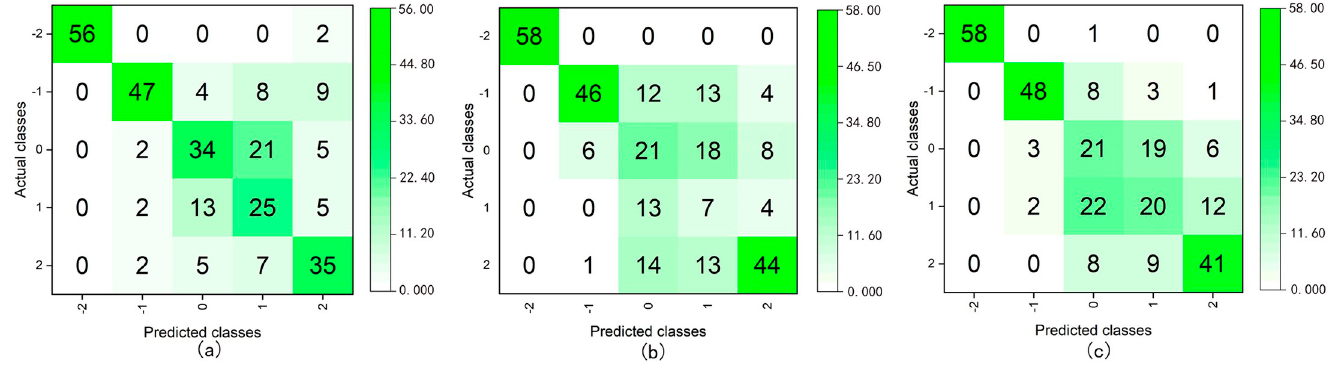
Fig 8. Confusion matrices of the quinary class classification using DT C5.0 (boosting) (a), RF (bagging) (b), and ANN (boosting) (c).